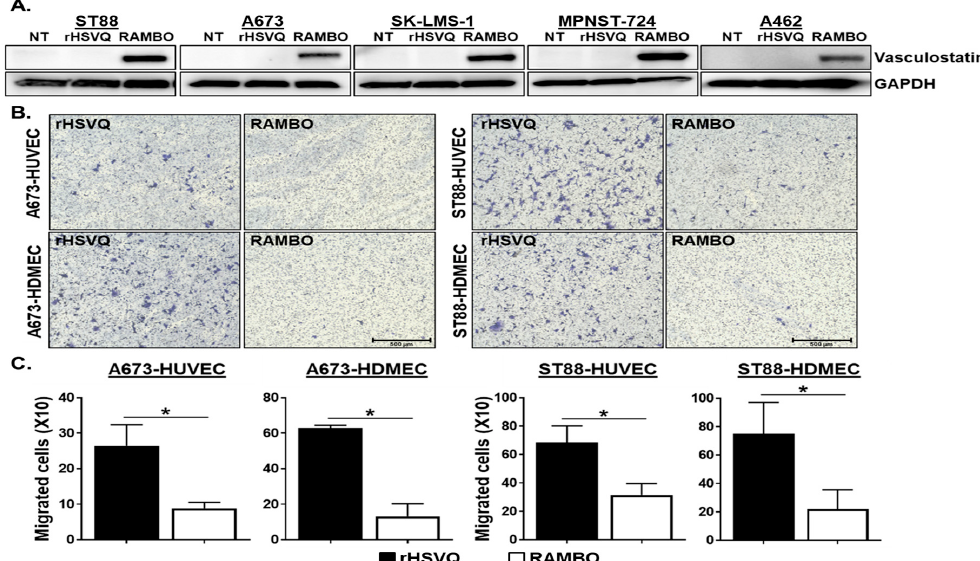
Figure 2. RAMBO expresses Vasculostatin in infected sarcoma cells and reduces endothelial cell migration. ( A ) RAMBO virus expresses Vasculostatin. Sarcoma cell lines (ST88, A673. SK-LMS-1, MPNST-724, and A462) were plated on 6 well plates and infected with 1 MOI of rHSVQ and RAMBO